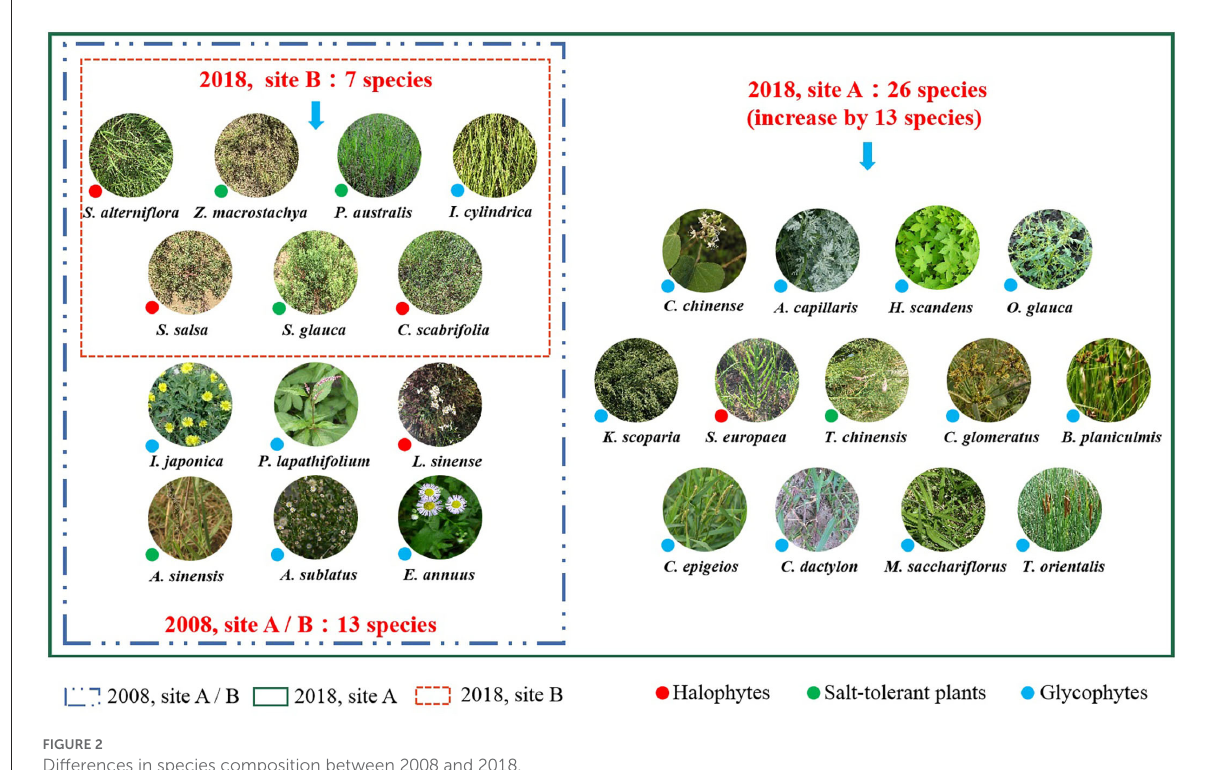
FIGURE2 Differences in species composition between 2008 and